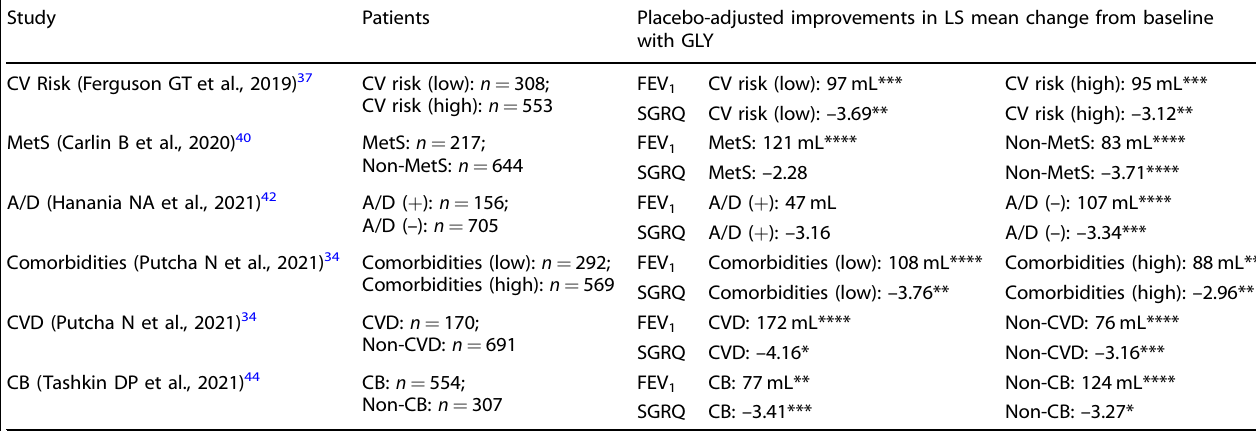
Table 3. Overview of secondary analyses of the GOLDEN 3 and 4 studies † , by comorbidities and chronic bronchitis at baseline. Study Patients Placebo-adjusted improvements in LS mean change from baseline with GLY CV Risk (Ferguson GT et al., 2019)